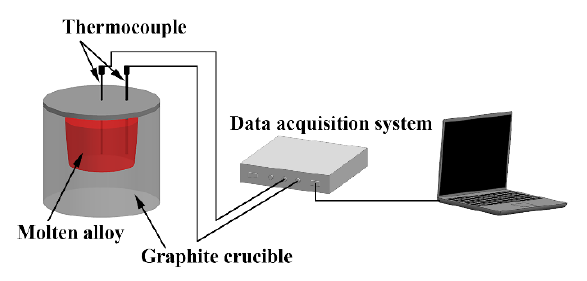
Figure 2. Schematic diagram of differential thermal analysis.